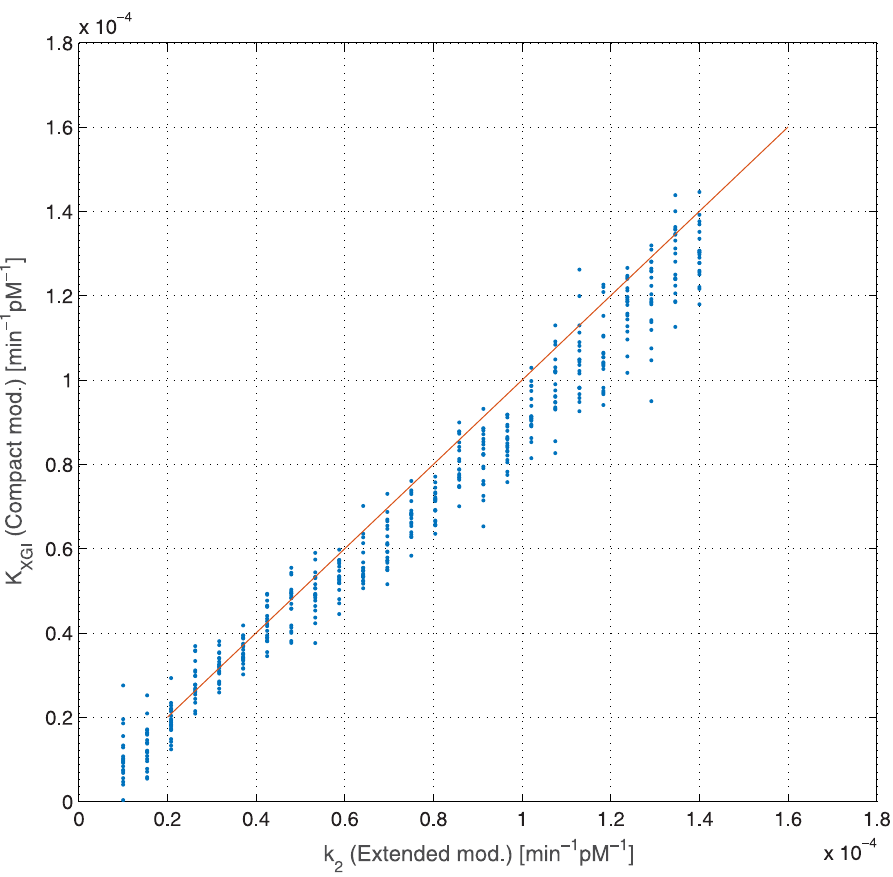
Fig 8. Dependence of estimated insulin sensitivity k XGI (Compact Model, with glycosuria term) from generating insulin sensitivity k 2 (Extended Model). Each dot represents a single virtual patient, while the line is the bisector k XGI = k 2 . Coefficient of correlation and its associated P-value: r = 0.98 ( P < 0.001).